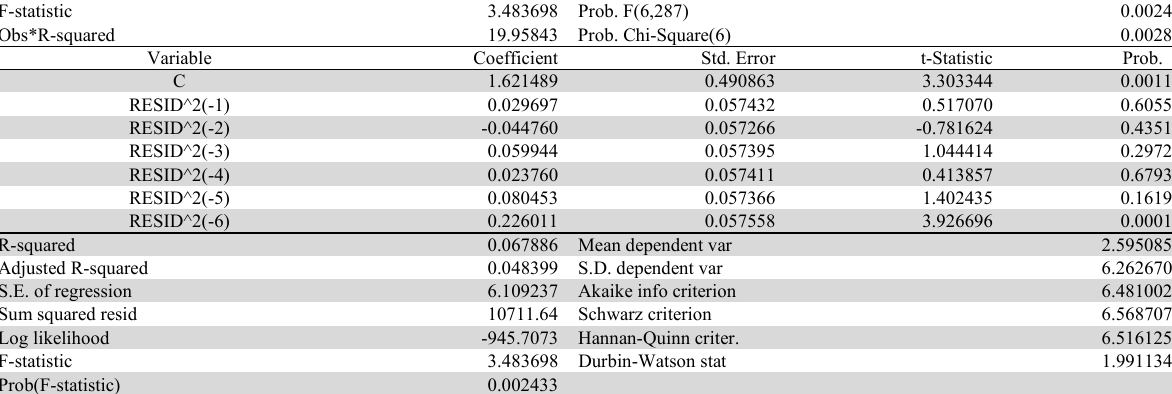
Exhibit the Pre-Estimation Model Output of Residual Diagnostics by ARCH LM-Test Using Least Squares Method